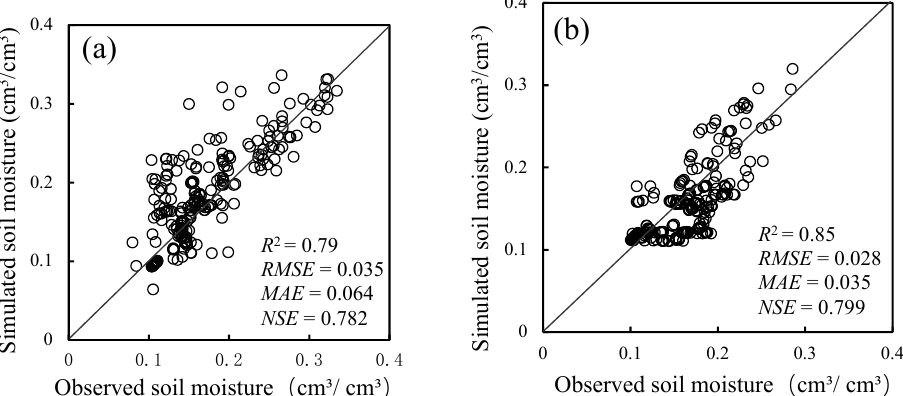
Figure 4. Comparison between the simulated and observed soil water contents: ( a ) the calibration period, and ( b ) the validation period, n=252.